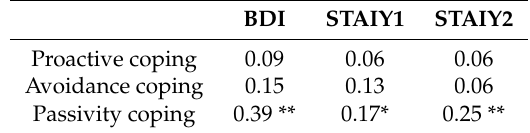
Table 7. Coping strategies, depression, anxiety: Pearson bivariate correlations in victims ( n = 180).